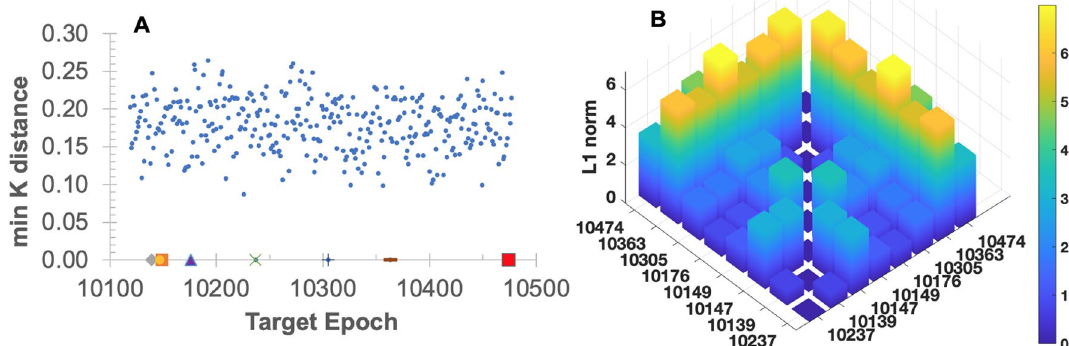
Figure 3. Uniqueness of large earthquakes’ Gauss curvature coordinates K of the pseudo physics quantities: (A) L1-norm distance of K of each epoch’s largest earthquake (i.e. largest event in one month) to the closest large earthquakes among the eight known earthquakes ( M w ≥ 7.0 ). (B) L1 norm distance of K among the eight large earthquakes ( M w ≥ 7.0 ) within 30 years. The closest two large events (epochs 10237 and 10139) are 0.73 apart in L1 norm of K , and the farthest two large events (epochs 10147 and 10363) are 6.99